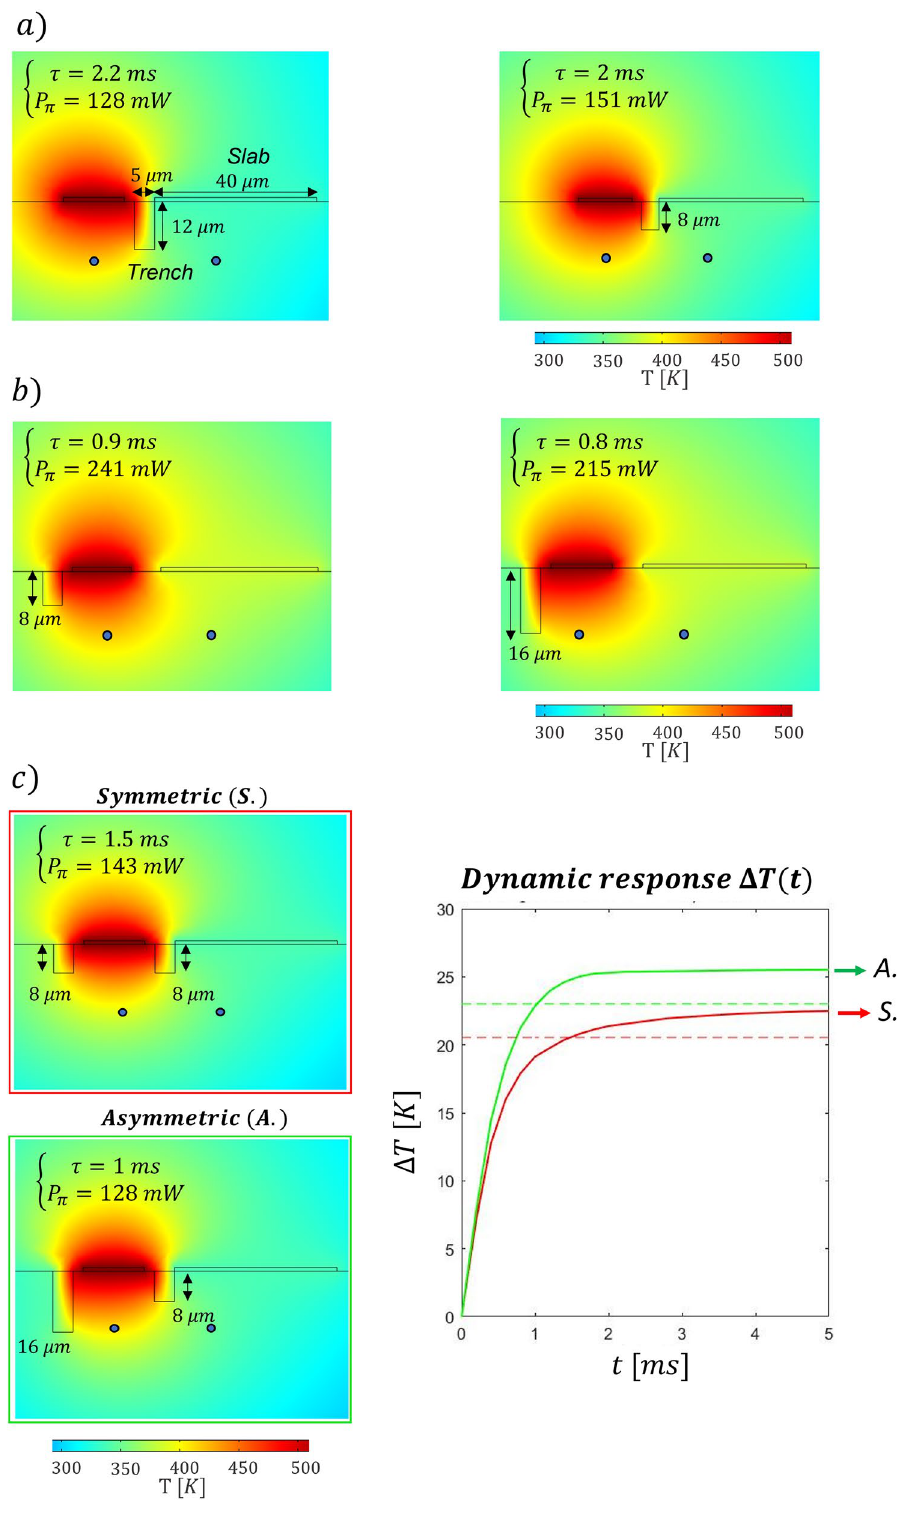
Figure 4. Simulated temperature distribution in different configurations under a power dissipation of 250 mW. Effect of the right-side ( a ) and left-side ( b ) trench on power consumption and system dynamics. Comparison of the symmetric (S.) and asymmetric (A.) configuration under a dissipated power of 250 mW ( c